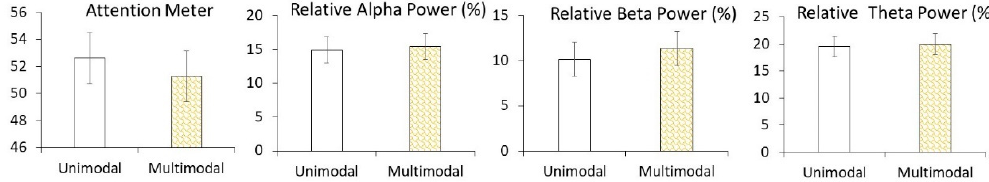
Figure 5. Mean EEG responses obtained in the unimodal and multimodal conditions. Error bars represent two standard error units.